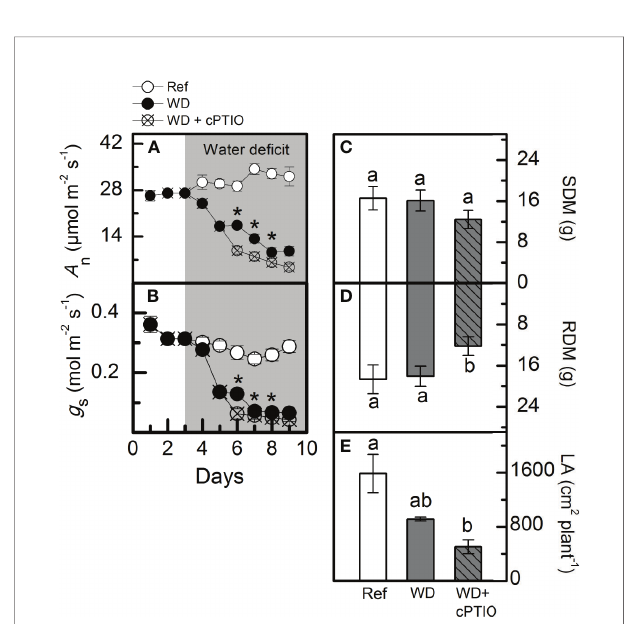
FIGURE 9 | Net CO 2 assimilation rate [ A n , in (A) ], stomatal conductance [ g S , in (B) ], shoot [SDM, in (C) ] and root [RDM, in (D) ] dry mass and leaf area [LA, in (E) ] of sugarcane plants supplied with only NO 3 − (100:0 NO 3 − :NH 4+ ) and maintained well-hydrated (reference, white symbols and bars), subjected to water de fi cit (WD, black symbols and gray bars) and subjected to water de fi cit and sprayed with cPTIO (WD+cPTIO, crossed symbols and gray striped bars). Symbols and bars represent the mean value of four biological replicates ± se. Asterisks indicate signi fi cant differences between treatments under water de fi cit (A , B) and different letters indicate statistical difference (BF 10 > 3) among treatments in a given